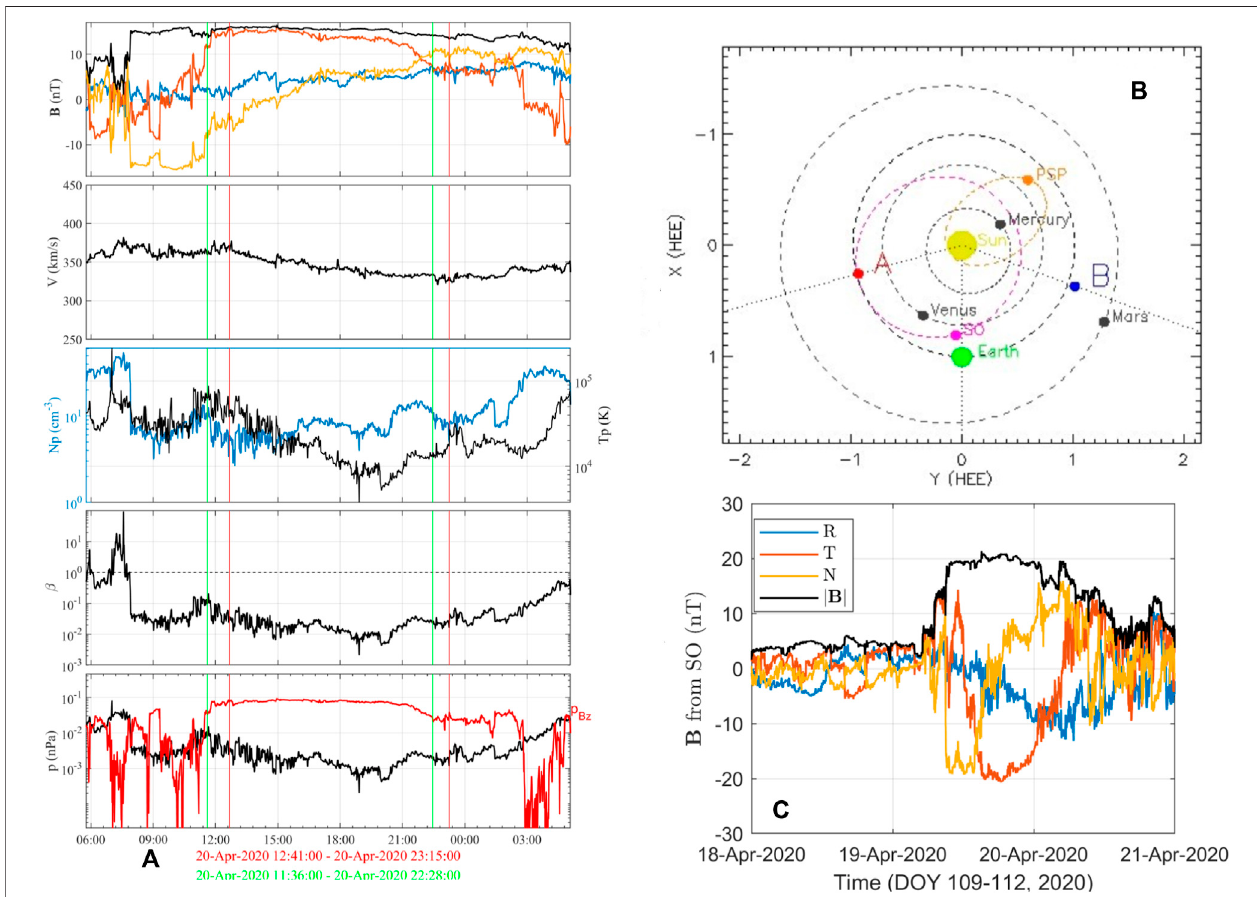
FIGURE 1 | (A) Time series data from Wind spacecraft (from top to bottom panels ) the magnetic fi eld components in GSE-X (blue), Y (red), and Z (gold) coordinates and the magnitude (black), the solar wind speed, the proton number density (blue; left axis) and temperature (black; right axis), the proton β , and the proton plasma pressure and the axial magnetic pressure (red). Two sets of vertical lines mark the intervals for the GS reconstruction (green) and the optimal fi tting to the Freidbergsolution(red),respectively,andaredenotedbeneaththelastpanel. (B) ThemultiplespacecraftandplanetslocationsaroundApril20,2020intheecliptic plane (courtesy of the STEREO Science Center). (C) The corresponding SO magnetic fi eld measurements in the RTN coordinates (see legend).